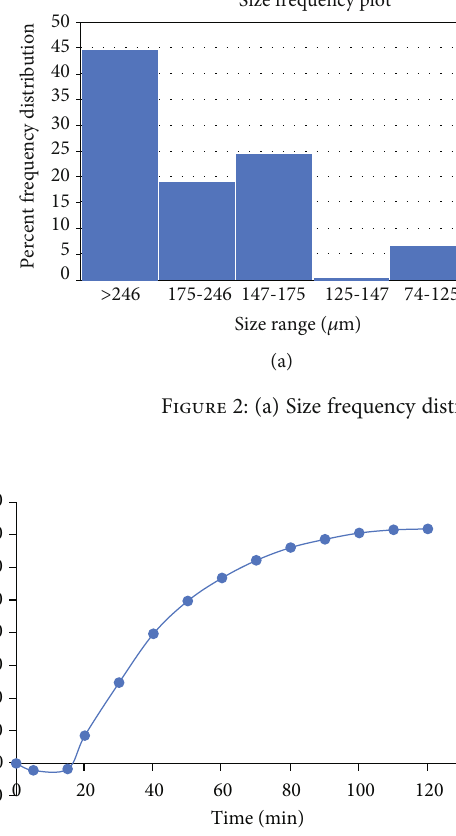
Figure 3: In vitro drug release pro fi le of polyherbal-based granules.